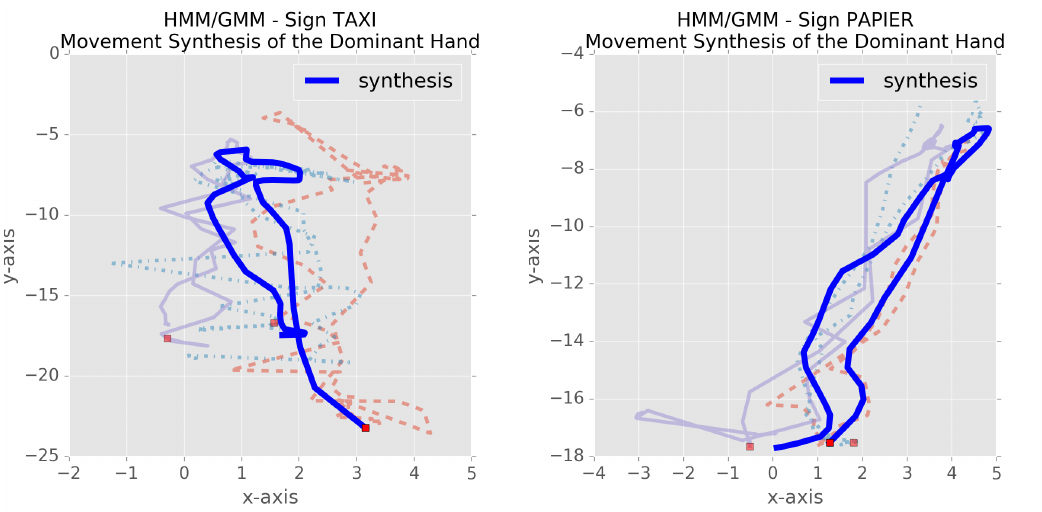
Figure 4. Movement synthesis of the dominant hand for the well-recognized sign, TAXI ( left ), and the poorly-recognized sign, PAPIER ( right ), using the Gaussian distribution sequence of the subunit-based HMM/GMM system, where the red square are the starting